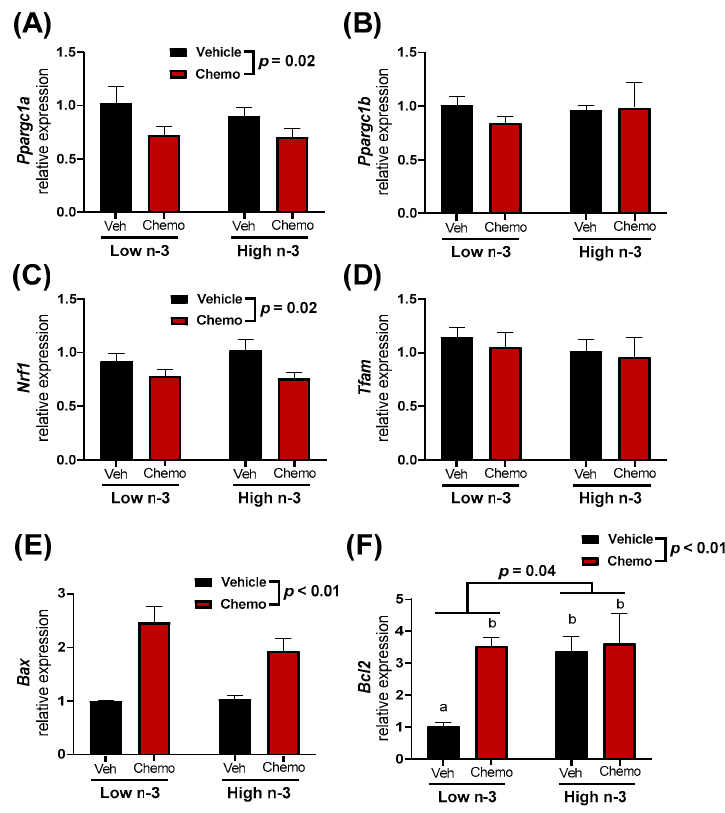
Figure 5. The heart mitochondrial-related gene expression of ( A ) Ppargc1a , ( B ) Ppargc1b , ( C ) Nrf1 , ( D ) Tfam , ( E ) Bax , and ( F ) Bcl2 . Data presented as group means ± SEM ( n = 5/group). A two- way ANOVA with a diet x chemo interaction was used to detect the differences between groups while pairwise comparisons were performed using a Tukey’s post hoc test. Group means with different lowercase letters were different at p < 0.05. Veh—saline vehicle injections; Chemo—9 mg/kg anthracycline + 90 mg/kg cyclophosphamide injections; Low n-3—0 g/kg EPA + DHA diet; High n-3—12.2 g/kg EPA + DHA diet (~2%